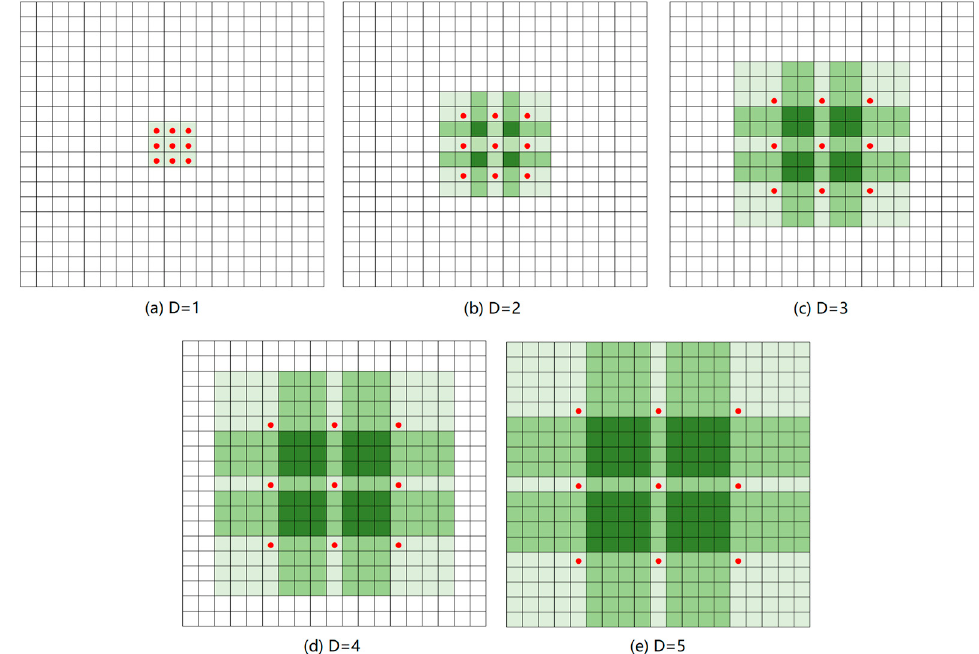
Figure 2. Examples of atrous convolution. The green boxes represent the size of the receptive field under different dilation rates. D represents the dilation rate.